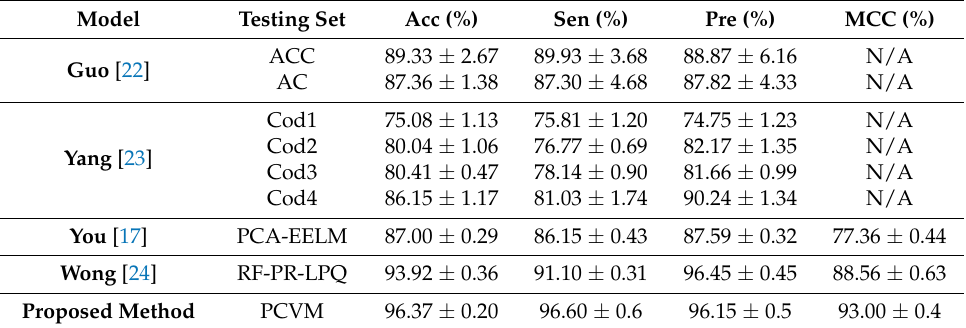
Table 6. Practical predicting results of different methods on the Yeast dataset. N/A: Not